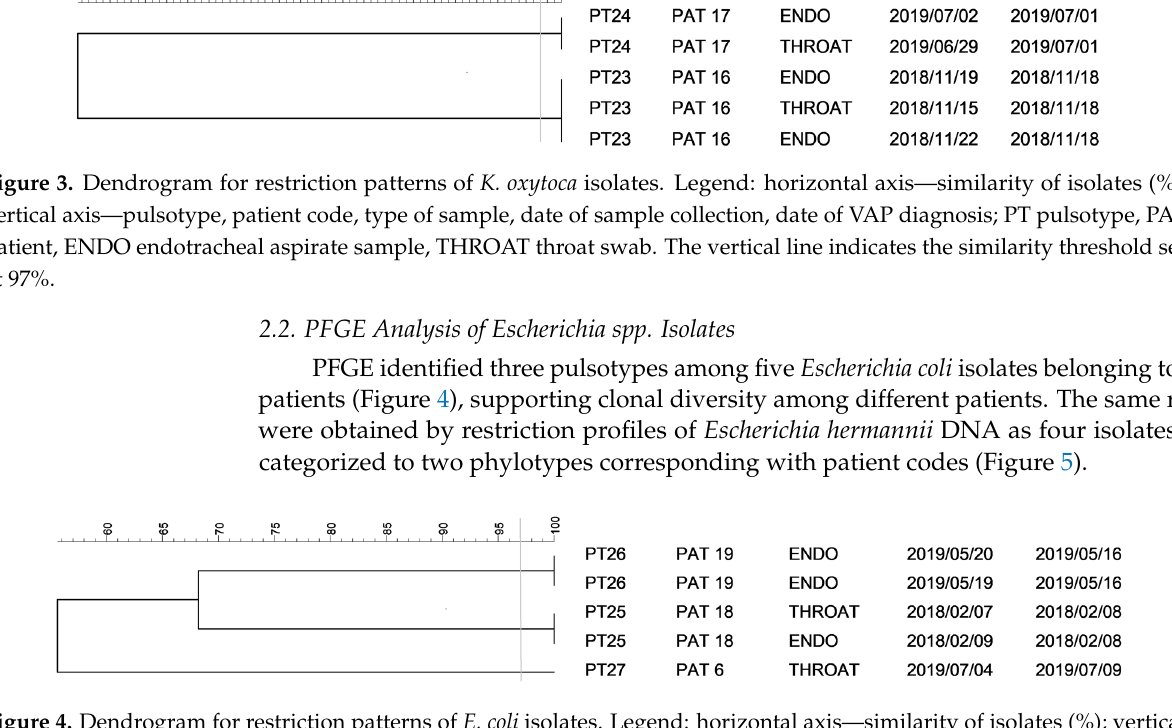
Figure 2. Dendrogram for restriction patterns of K. variicola isolates. Legend: horizontal axis—similarity of isolates (%); vertical axis—pulsotype, patient code, type of sample, date of sample collection, date of VAP diagnosis; PT pulsotype, PAT patient, ENDO endotracheal aspirate sample, THROAT throat swab. The vertical line indicates the similarity thresh- old set at 97%.